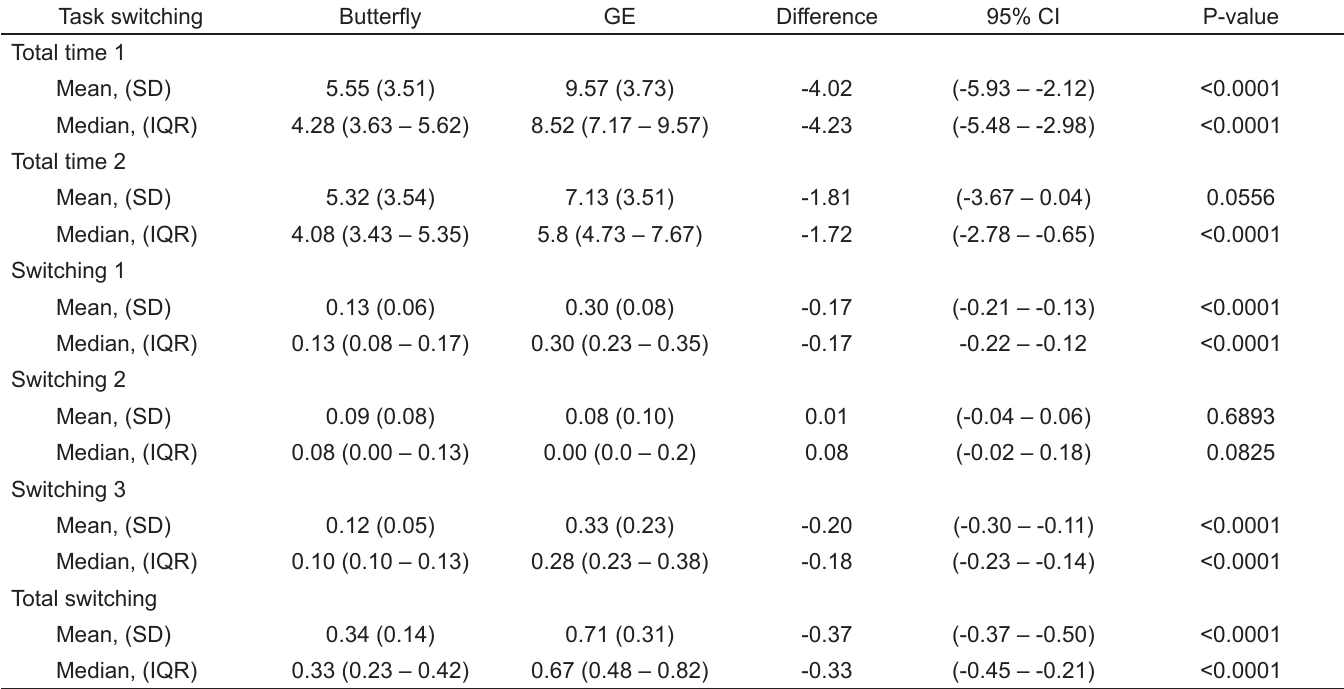
Table 3. Comparison of task-switching time, handheld Butterfly vs GE cart-based ultrasound